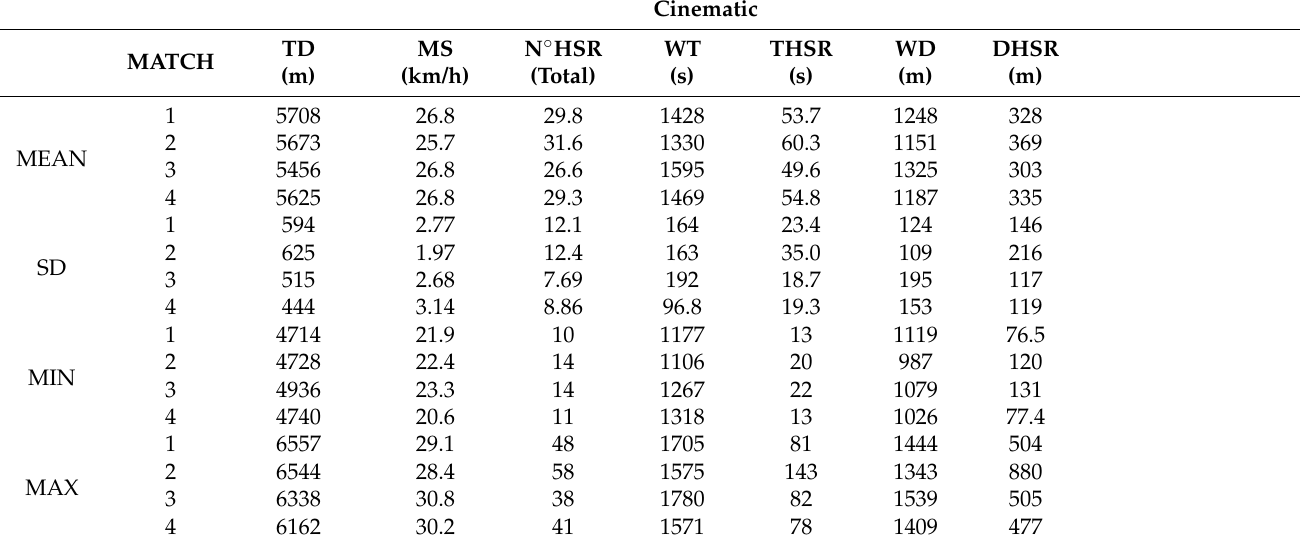
Table 3. Descriptive statistics of the external load indicators for each official